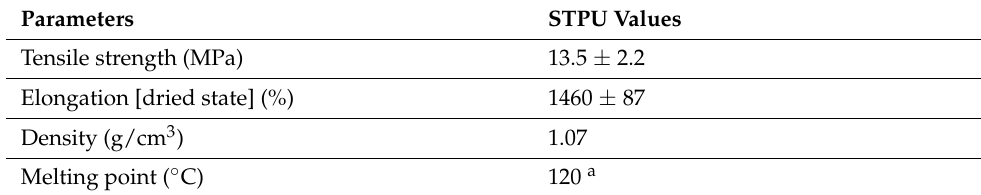
Table 2. Physical properties of